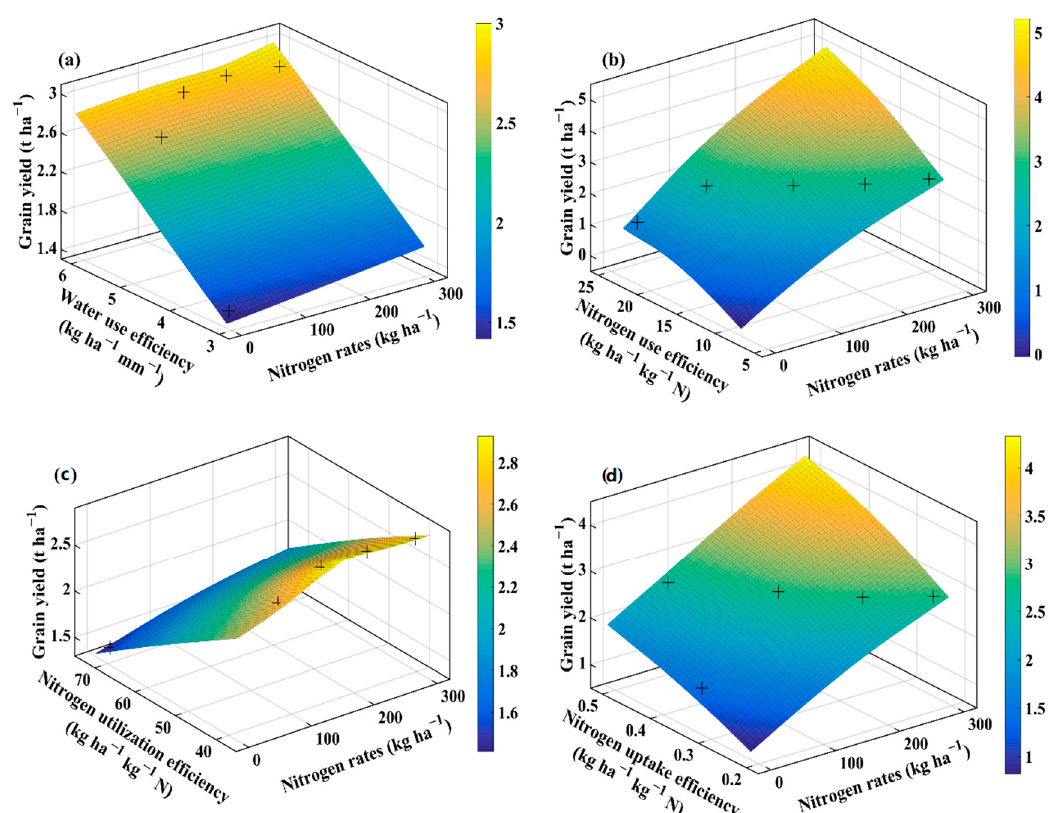
Figure 7. Thin plate smoothing spline plots showing the interaction of N rates ( x -axis) with water use efficiency, nitrogen use efficiency, nitrogen utilization efficiency, and nitrogen uptake efficiency ( y -axis) on average grain yield ( z -axis) in the 2014–2015 growing season. The various panels show water use efficiency ( a ); nitrogen use efficiency ( b ); nitrogen utilization efficiency ( c ); and nitrogen uptake efficiency ( d ) for the 2014–2015 growing season, respectively. + indicates the observed data.